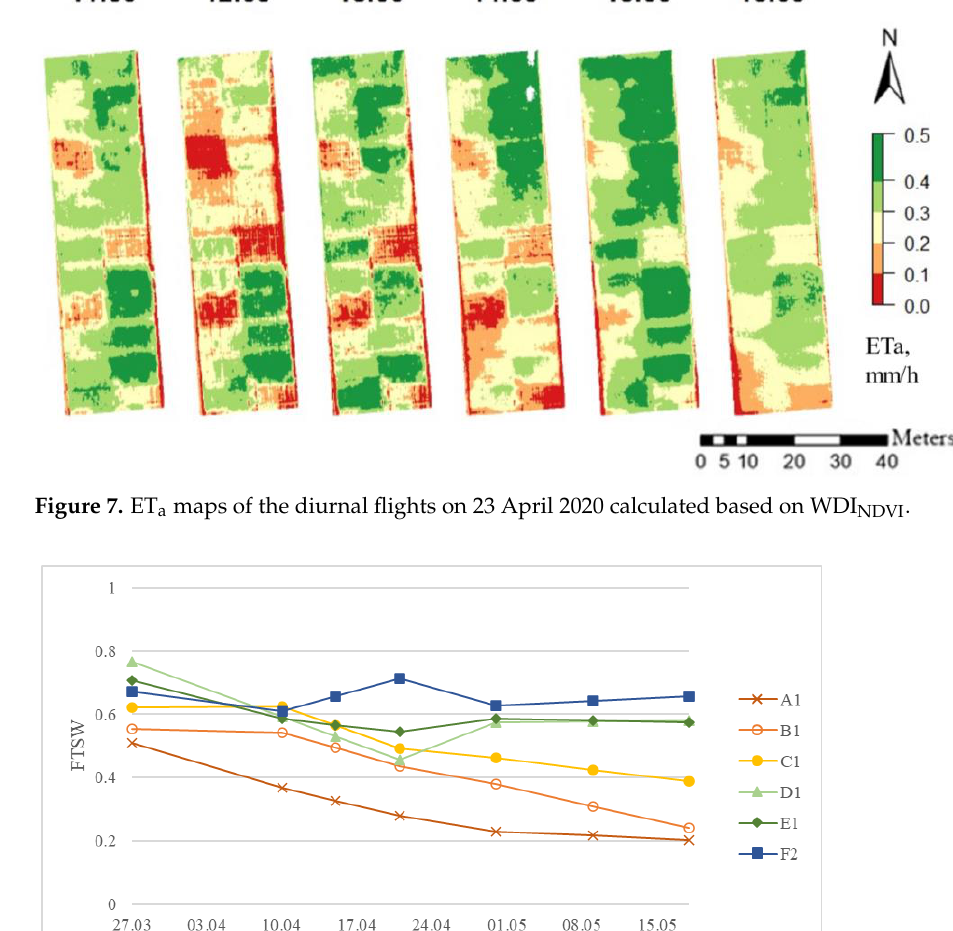
Figure 9. WDI and ET correlations to fraction of transpirable soil water (FTSW) at various root depths for the April–May of 2019. Grey color in the cells visually represents the correlation value.